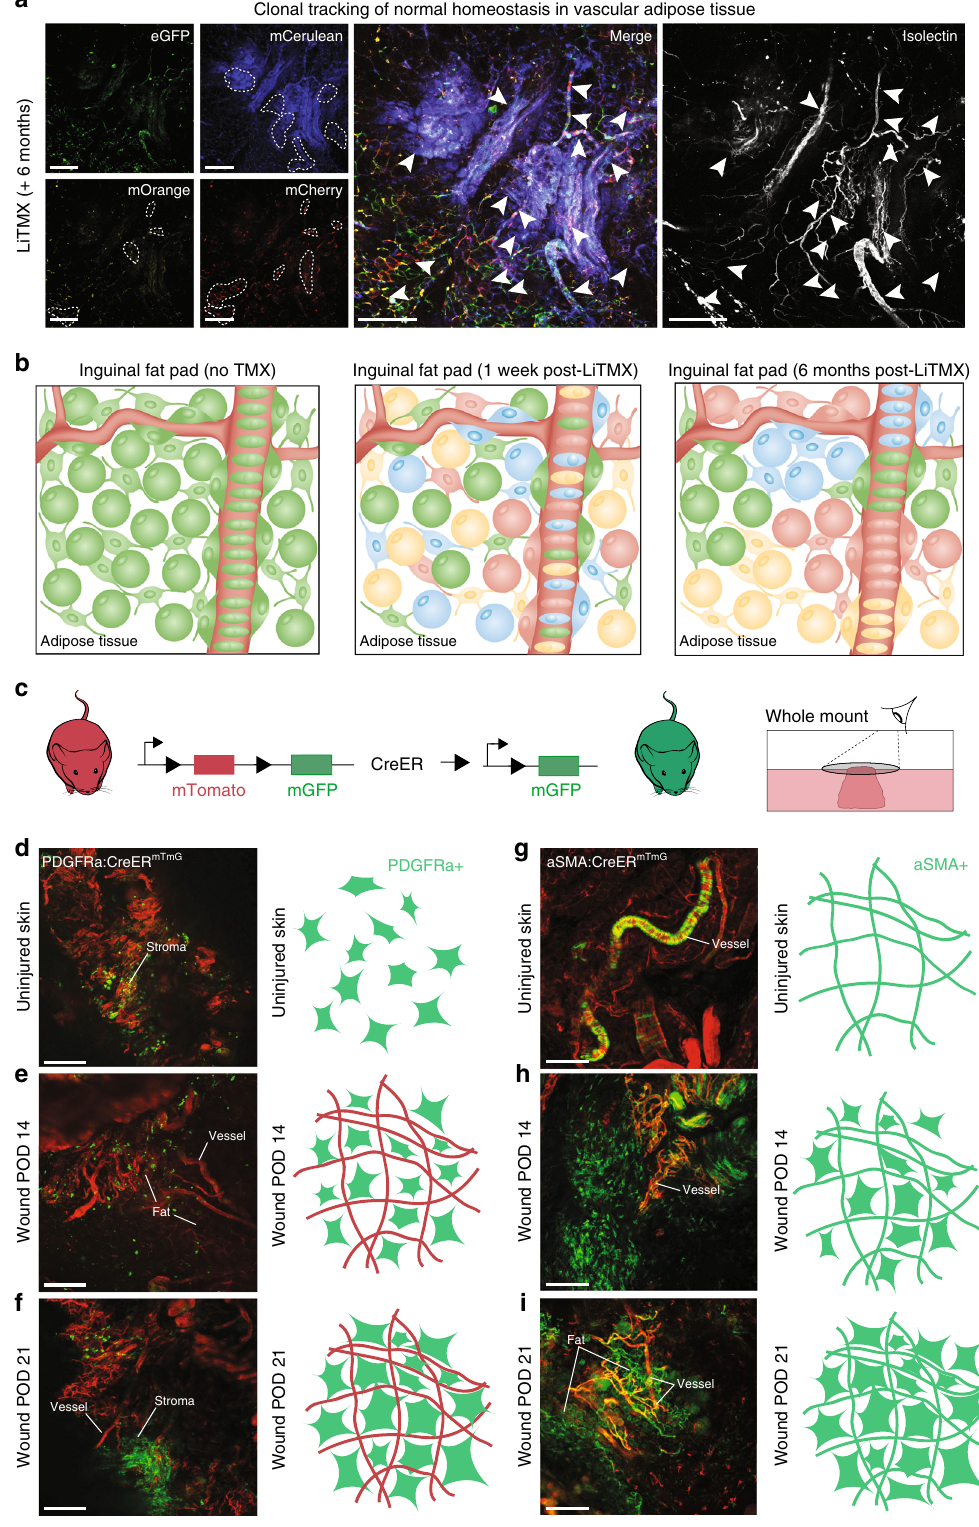
Application to long bone . Gli1-CreER T2 :: Rosa26-mTmG and Rainbow ( Actin-CreER T2 :: Rosa26-VT2/GK3 ) mice were placed under anesthesia and analgesia as described and placed in the supine position. A longitudinal incision was made in the skin parallel to the long bone, subcutaneous fat and muscles were divided parallel to muscle fi bers. Dose of 10 μ g, unless otherwise speci fi ed, of 4-hydroxytamoxifen or LiTMX was applied to the surface of the periosteum using